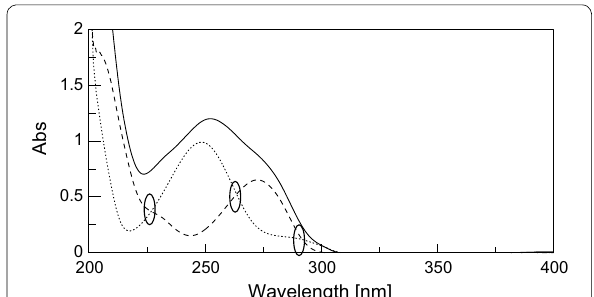
Fig. 5 Zero order absorption spectra of 10 μg/mL PCT ( dotted line ) and CAF ( dashed line ) showing 3 isoabsorptive points at 226.9 263.6 and 292 nm and the binary mixture of CAF and PCT 10 μg/mL of each